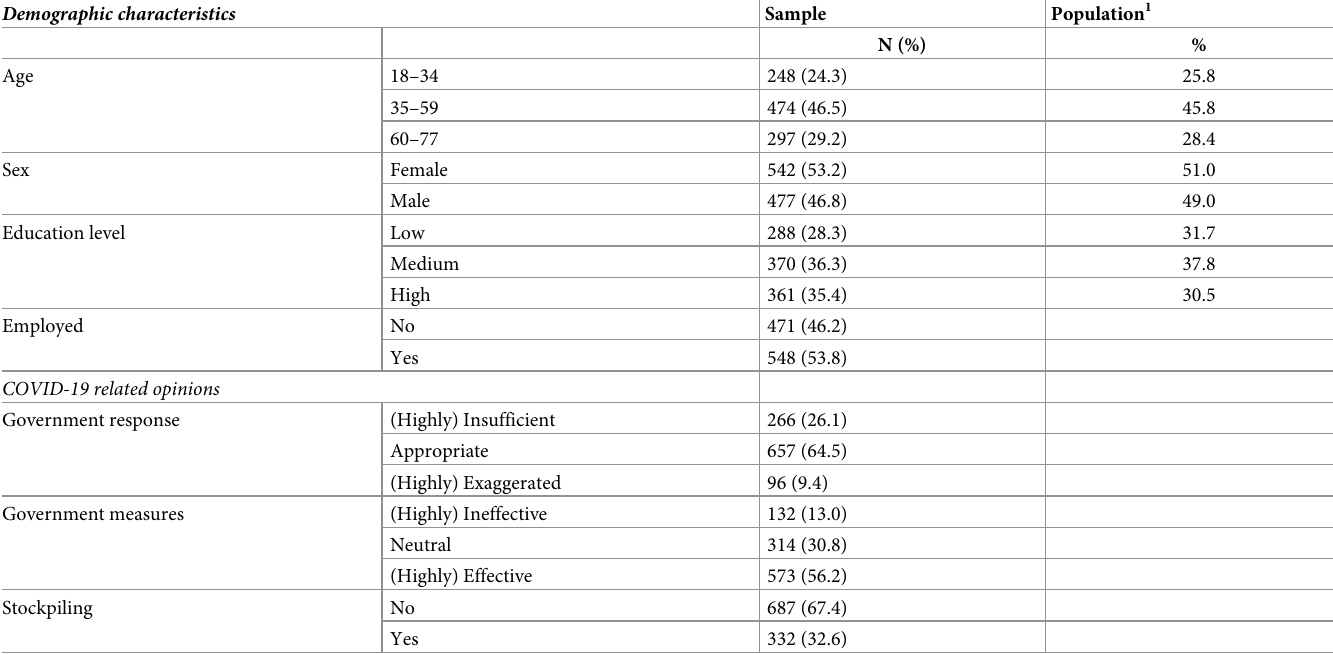
Table 3. Demographic characteristics and COVID-19-related opinions of the study sample ( N = 1,019) and proportions in overall population.